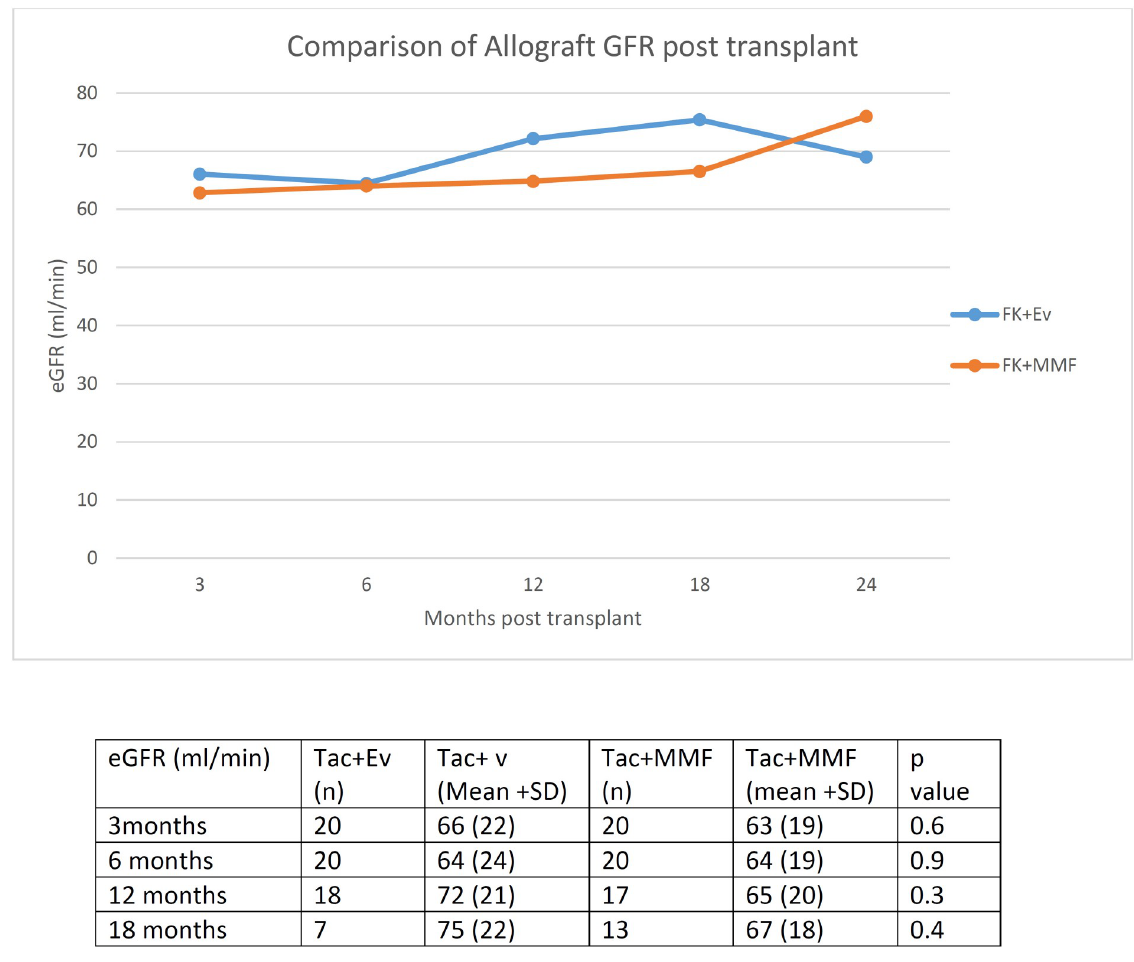
Fig 3. Comparison of post-transplant estimated GFR between study